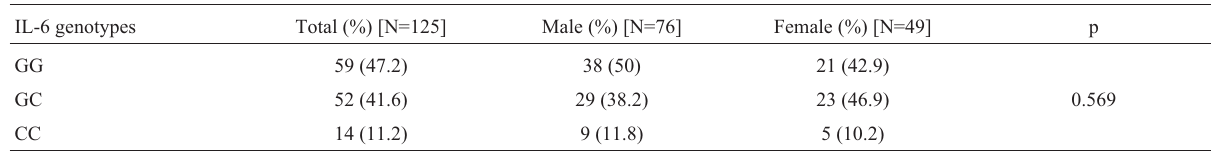
Table 2 - Distribution of IL-6 –174 G/C (SNP rs1800795) genotypes in relation to the total number of subjects and gender. The results are expressed as a percentage (%) in relation to the total sample size of each group. IL-6